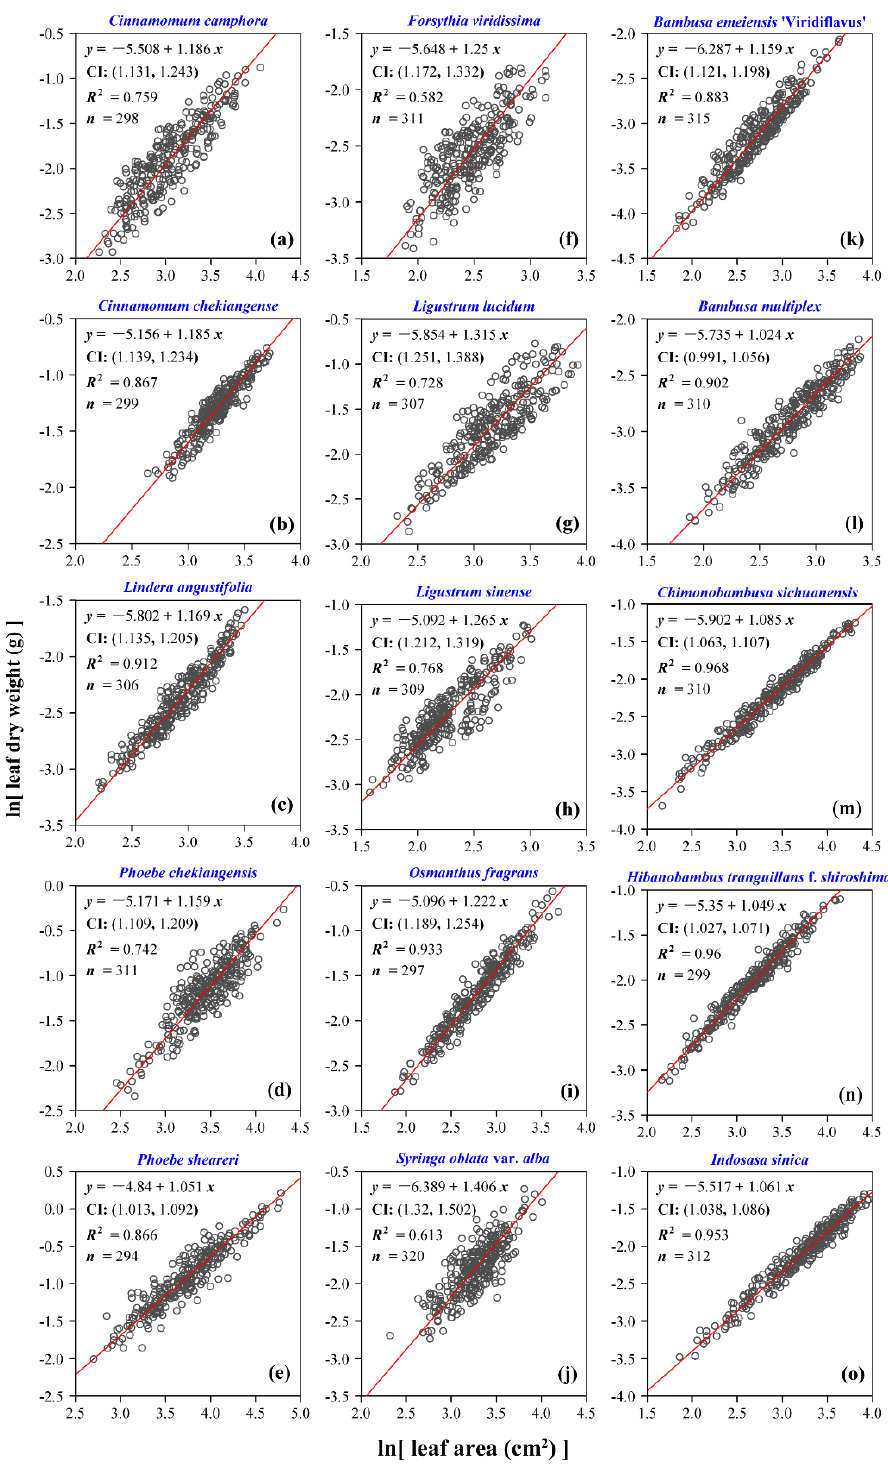
Figure 6. Scaling relationship of leaf dry weight to leaf area at individual species level. Panels ( a – e ) belong to Lauraceae, panels ( f – j ) belong to Oleaceae, and panels ( k – o ) belong to Bambusoideae. In each panel, the open circles represent the observations, and the red straight line represents the reduced major axis regression line. Furthermore, y represents the natural logarithm of leaf dry weight in g, x represents the natural logarithm of leaf area in cm 2 , CI represents the 95% confidence interval of the slope, R 2 is the coefficient of determination used to measure the goodness of fit, and n represents the number of leaves sampled.